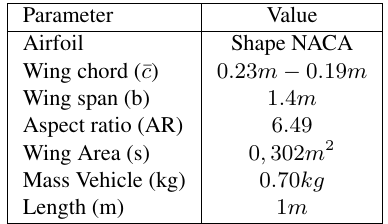
Table 3: Parameters of the airplane.